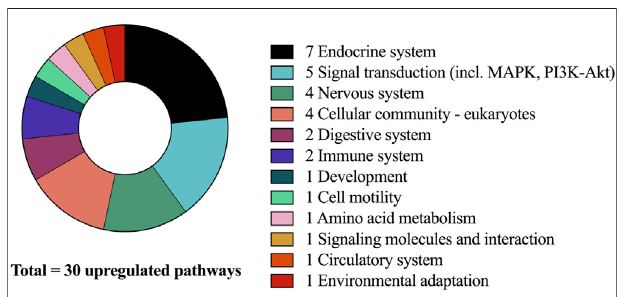
Frontiers in Physiology |